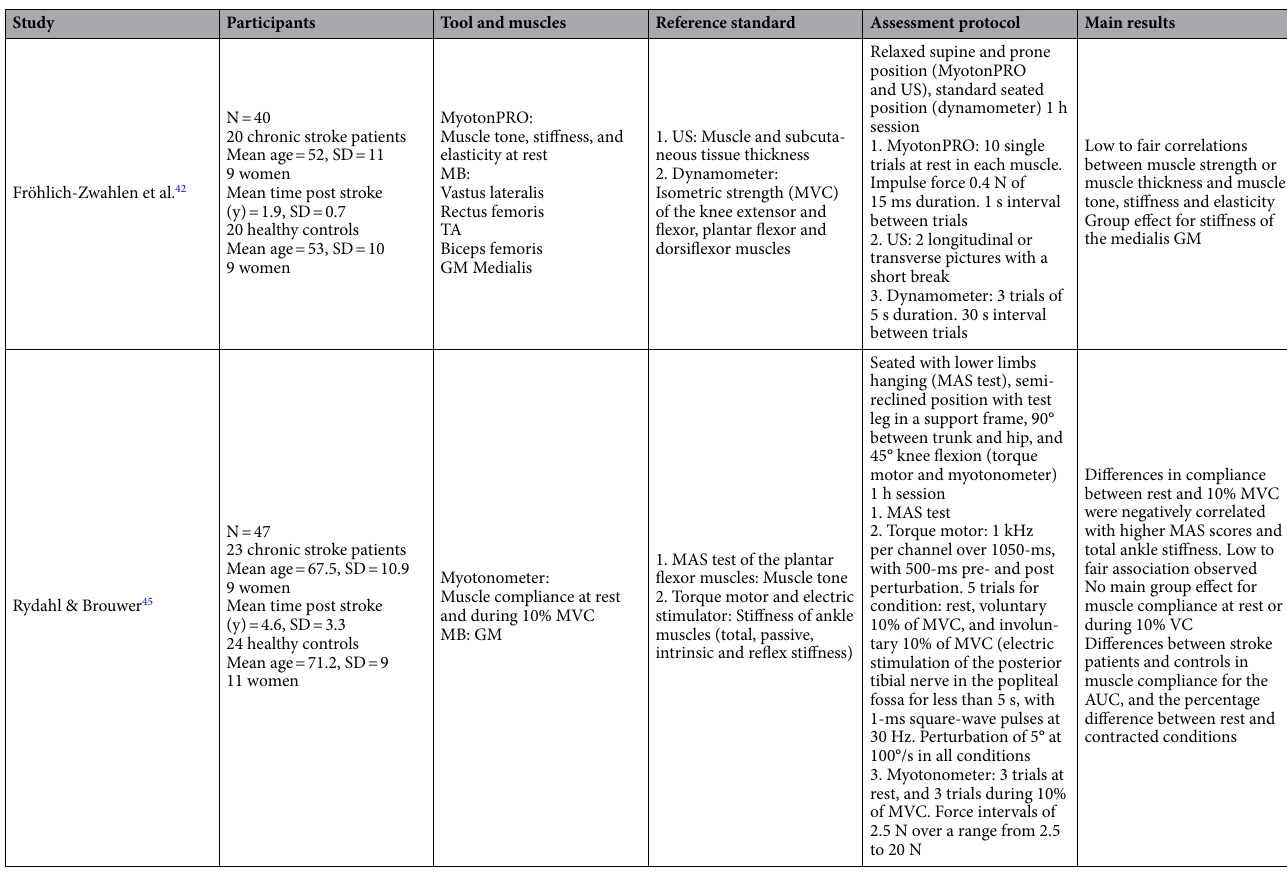
Table 2. Main characteristics of selected studies analyzing validity of the myotonometry in the lower limbs. AUC: area under the curve; GM: gastrocnemius muscle; N: newton; MB: muscle belly; MVC: maximal voluntary contraction; TA: tibialis anterior; US: